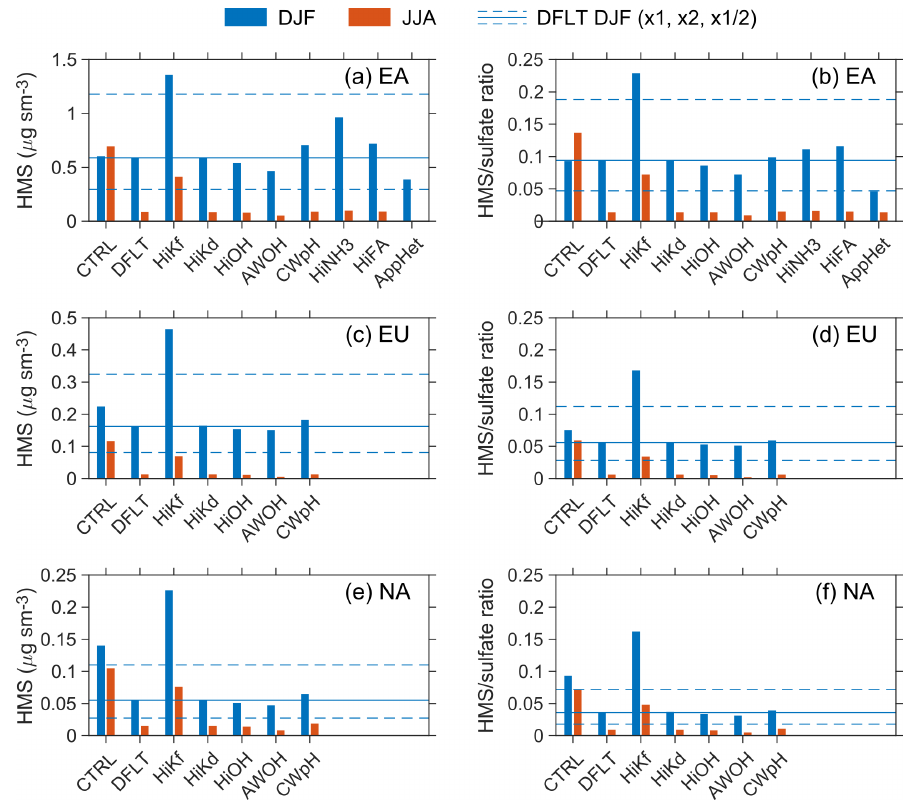
Figure 5. Comparison of the modeled surface HMS concentrations (a, c, e) and HMS / sulfate molar ratios (b, d, f) from different simulations for three regions and two seasons. EA, EU, and NA are East Asia, Europe, and North America, respectively. DJF and JJA represent December– January–February and June–July–August, respectively. The solid and dashed lines indicate the DJF value from the default (DFLT) simulation and its double and half. The vertical axis differs in the left